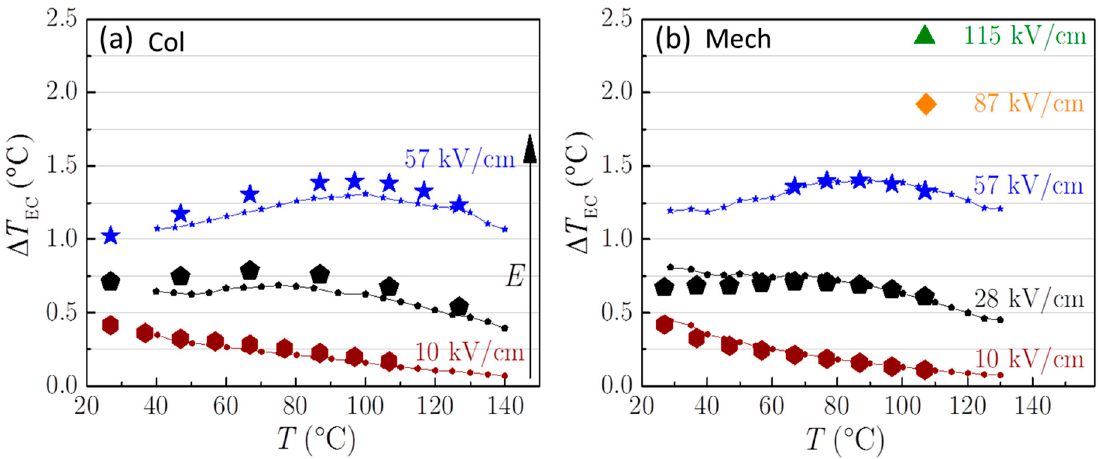
Figure 2. ∆ T EC ( T ) at a few selected electric fields for the ( a ) Col and ( b ) Mech samples. The larger and smaller symbols represent the results of the direct and indirect EC measurements, respectively. Lines are a guide for the eye. The arrow indicates the increase in the electric field. Here, naturally, the question arises: why do the Mech ceramics withstand approximately two-times higher electric fields than the Col ceramics? The thicknesses of the investigated samples and the areas of the electrodes were similar, therefore, the impact of the measurement conditions can be excluded. Joule heating was not detected during the direct EC measurements, irrespective of the synthesis method, the temperature, and the applied electric field.